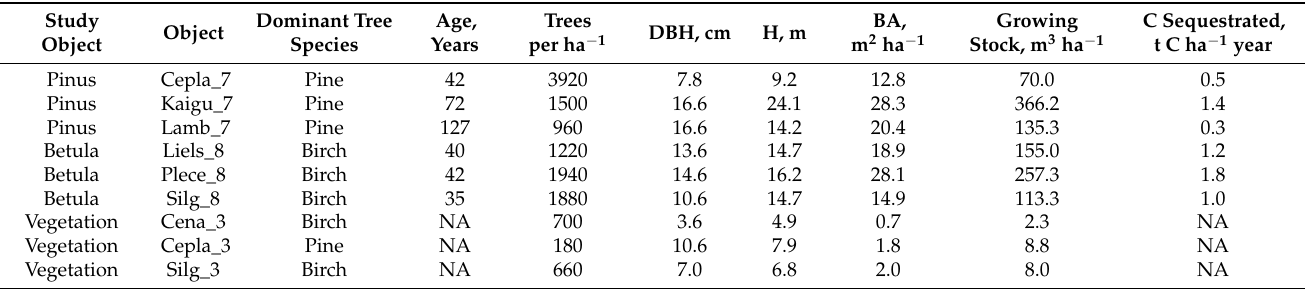
Table 3. Taxation indices of afforested study objects. DBH—diameter at breast height, H—tree height, BA—basal